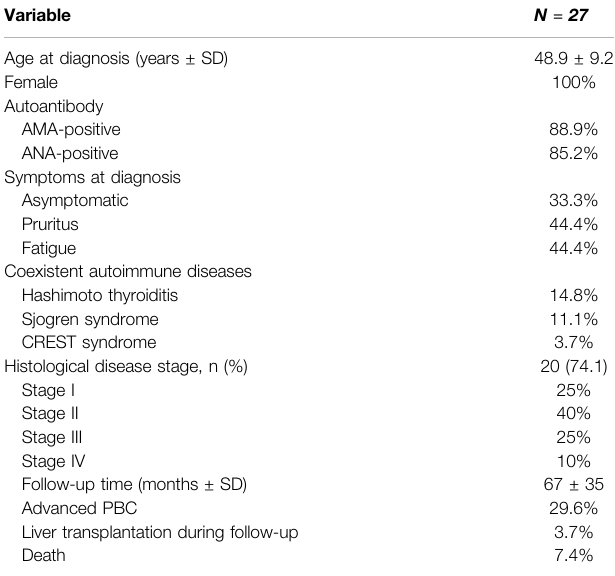
TABLE1| Baselinecharacteristicsofpatientswithprimarybiliarycholangitisusing fi brates. Variable